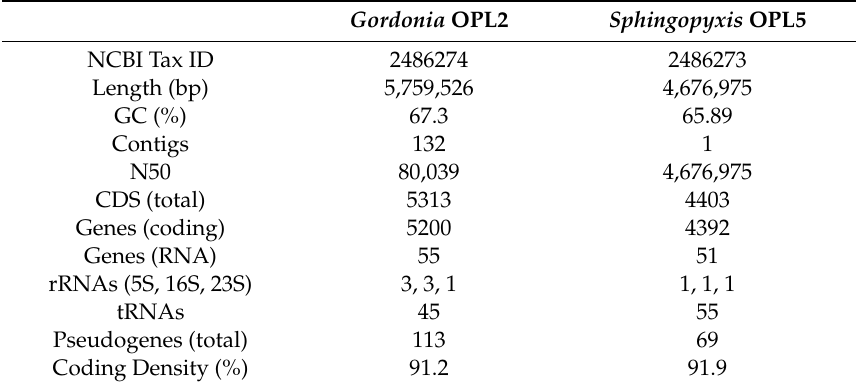
Table 1. General characteristics of the genomes of Gordonia strain OPL2 and Sphingopyxis strain